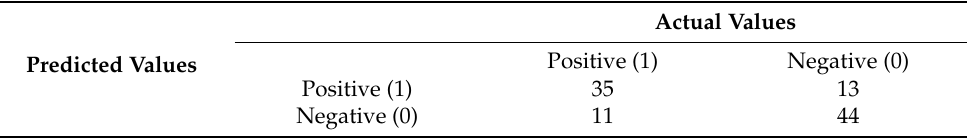
Table 4. The confusion matrix for the FSL-CNN